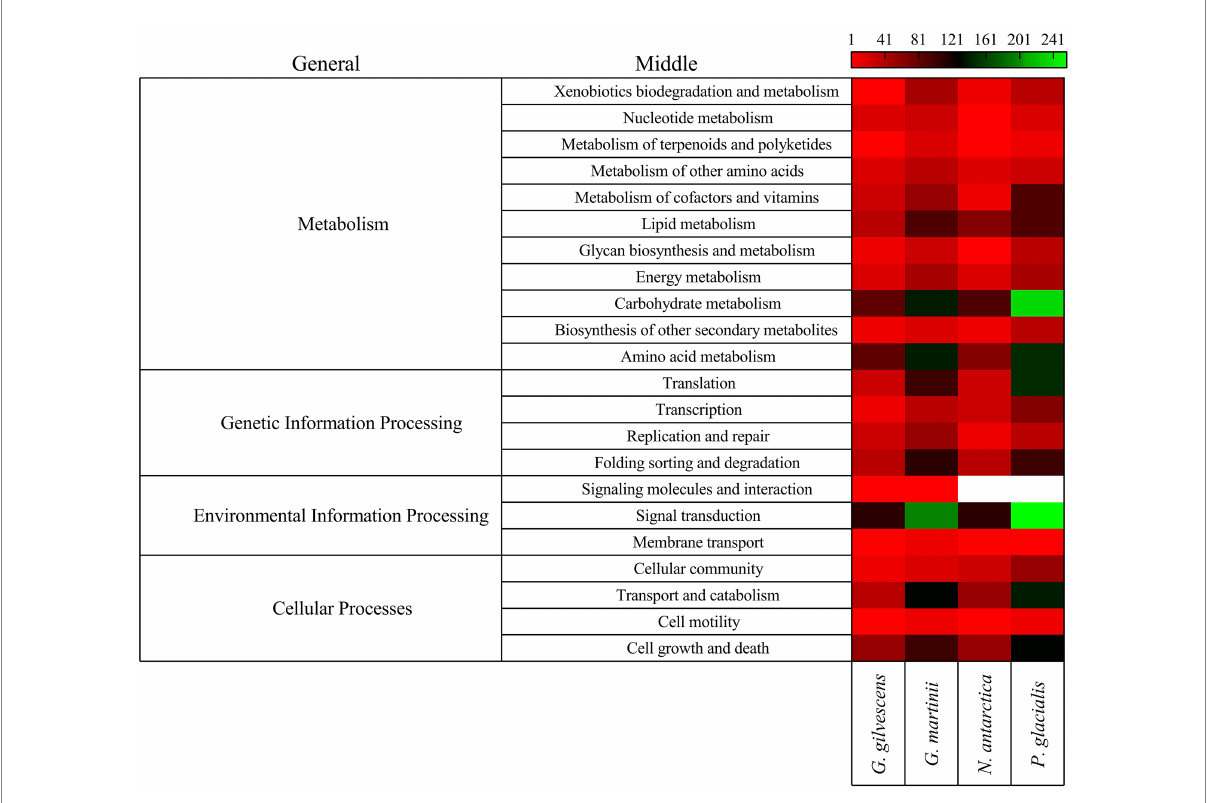
FIGURE 2 Classification of CDS by metabolic pathways. The CDSs were classified by comparison using GHOST X tools of the KAAS-KEGG Automatic Annotation Server. The number of CDSs grouped according to general and middle pathways are